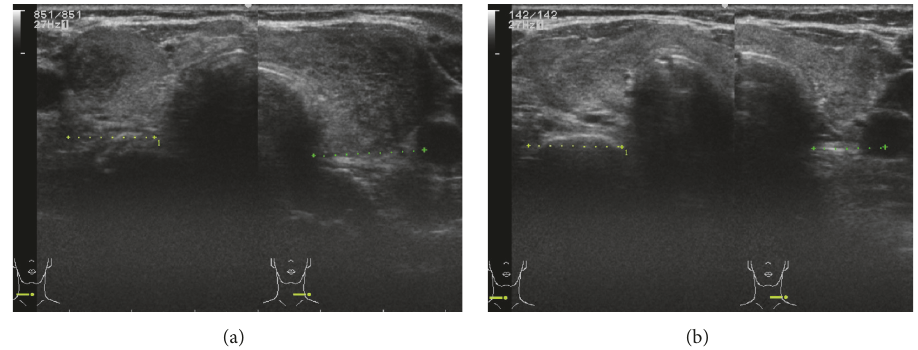
Figure 1: Ultrasonography of the thyroid. (a) Heterogeneous and hypoechoic areas were observed in both thyroid lobes before treatment. (b) Hypervascularity and a reduction in hypoechoic areas, indicating improvement, were observed 10 weeks after treatment initiation.